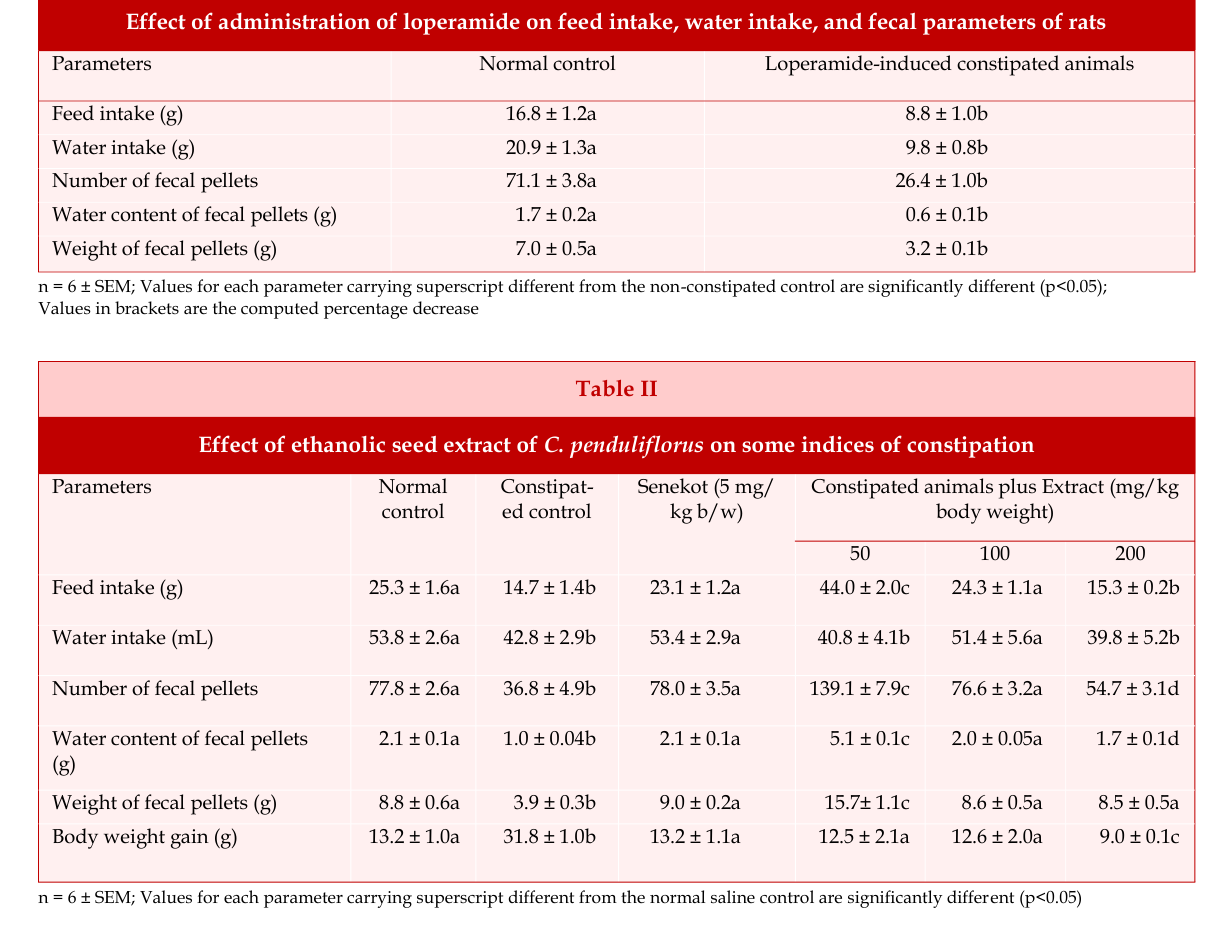
Statistical analysis